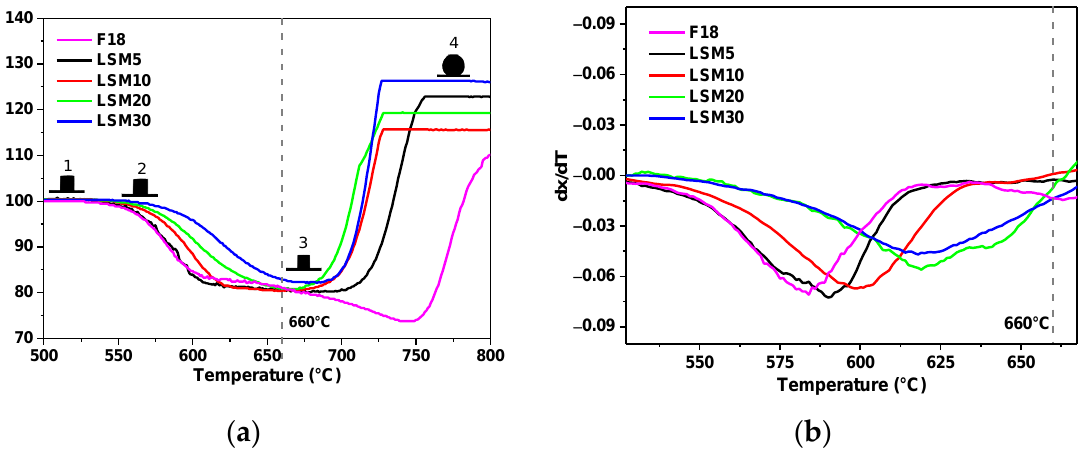
Figure 2. Sintering Curves of composites. ( a ) Sample area vs. Temperature (Shrinkage Curve) estimated errors F18 ± 0.6%/5LSM ± 2.7%/10LSM ± 1.1%/20LSM ± 4.0%/30LSM ± 0.5%. These images 1 to 4 represents the specific temperatures (1) Sintering Temperature, (2) Softening Temper- ature, (3) Maximum densification temperature and (4) expansion ( b ) Maximum densification rate vs. Temperature. Table 1. Sintering Temperature ( T s ), Softening Temperature ( T a ), Maximum densification tempera- ture ( T max ) in sintering saturation. The typical error in these temperatures is ±5 °C.